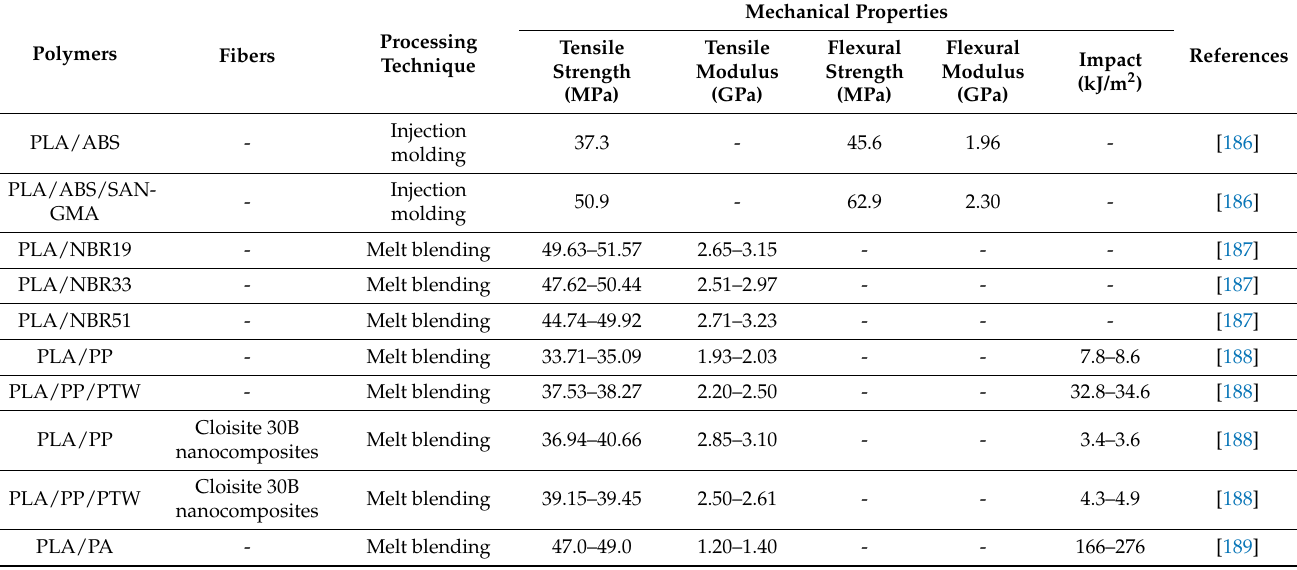
Table 8. Mechanical properties of PLA blend